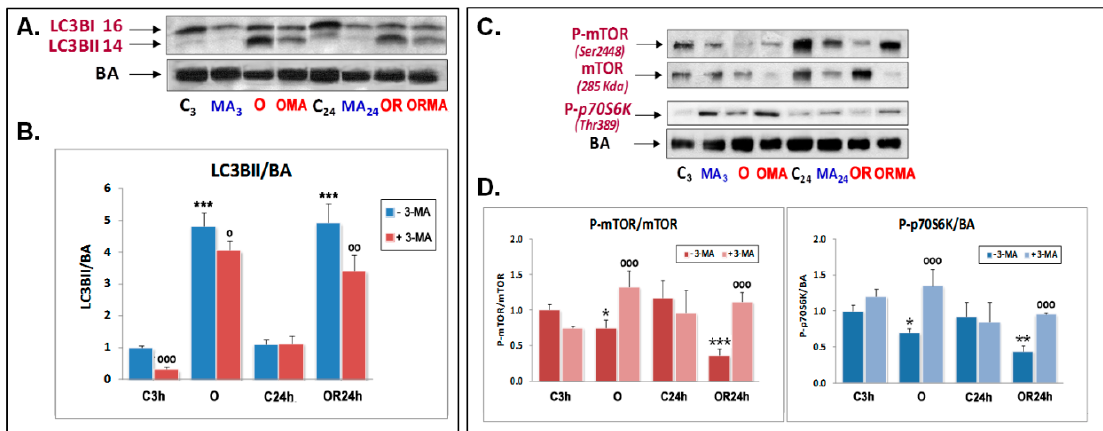
Figure 1. E ff ect of oxygen and glucose deprivation (OGD), oxygen and glucose deprivation and resupply (OGDR), and 5 mM 3-methyladenine (3-MA) treatment on LC3B lipidation ( A , B ) and mTOR and p70S6K phosphorylation ( C , D ) in cultured cortical neurons. ( A , B ) Western blot analysis of LC3BI and LC3BII was performed in extracts of cortical neurons subjected to 3 h OGD exposure (O) and subsequent 24 h OGDR (OR) compared to their respective controls. ( A ) Representative LC3B I and II and β -actin (BA) Western blots are shown. ( B ) Quantitative analysis of the LC3BII / BA ratio. Data are expressed as ratios over basal control and are mean ± SEM of three experiments, each one performed in duplicate. ( C , D ) Western blots of mTOR, 2448 SerP-mTOR, and 389 ThrP-p70S6K were performed in the aforementioned conditions. Upper panel ( C ) shows a representative Western blot of these proteins. Lower panels ( D ) shows the quantification of the indicated ratios and are mean ± SEM of three experiments, each one performed in duplicate. Statistics in panels ( B ) and ( D ) compare the e ff ect of O and OR over their respective controls C3 and C24h, respectively (***) and the e ff ect of 5 mM 3-MA in each condition, in the absence or presence of this compound ( ooo ), at * / o p < 0.05, ** / oo p < 0.01, and *** / ooo p < 0.001) (one-way ANOVA